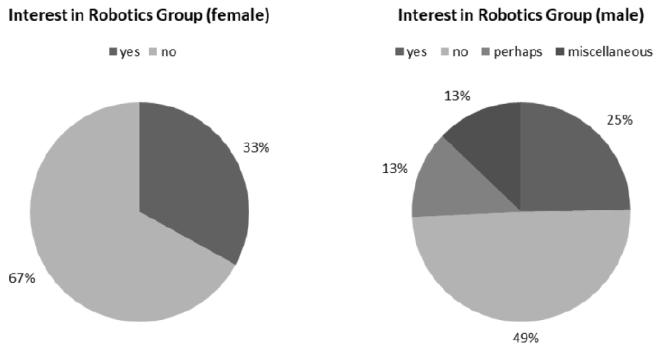
Fig. 7. Vocabulary training: Interest in robotics